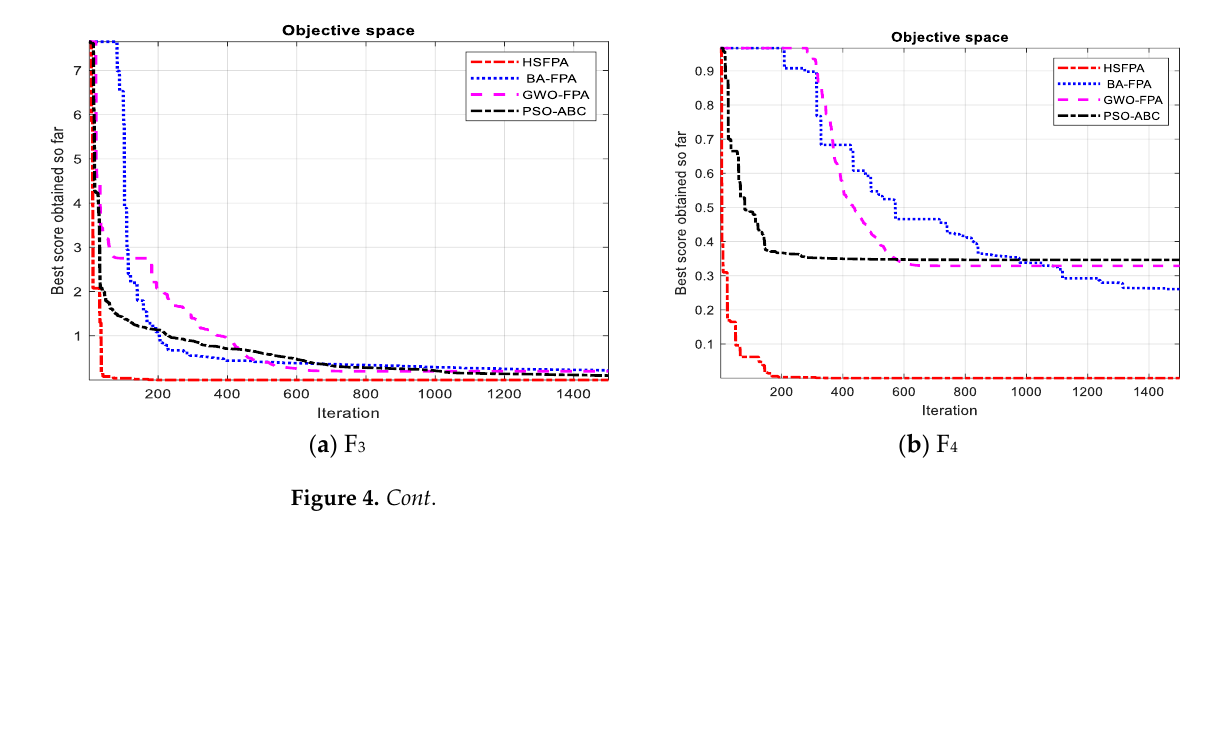
( f ) F 12 Figure 4. Comparative curves of the evaluated performance of the proposed HSFPA with the FPA, MFPA, and PSO algorithms for the testing function of F 3 , F 4 , F 5 , F 7 , F 11 , F 12 as in subfigures: ( a – f ), respectively. 4. Application of the HSFPA for Microgrid Operations Planning This section presents the multiobjective function for the microgrid operational plan- ning issues, optimizing process steps, and analyzing and discussing the results. The de- tailed presentation is described as follows.